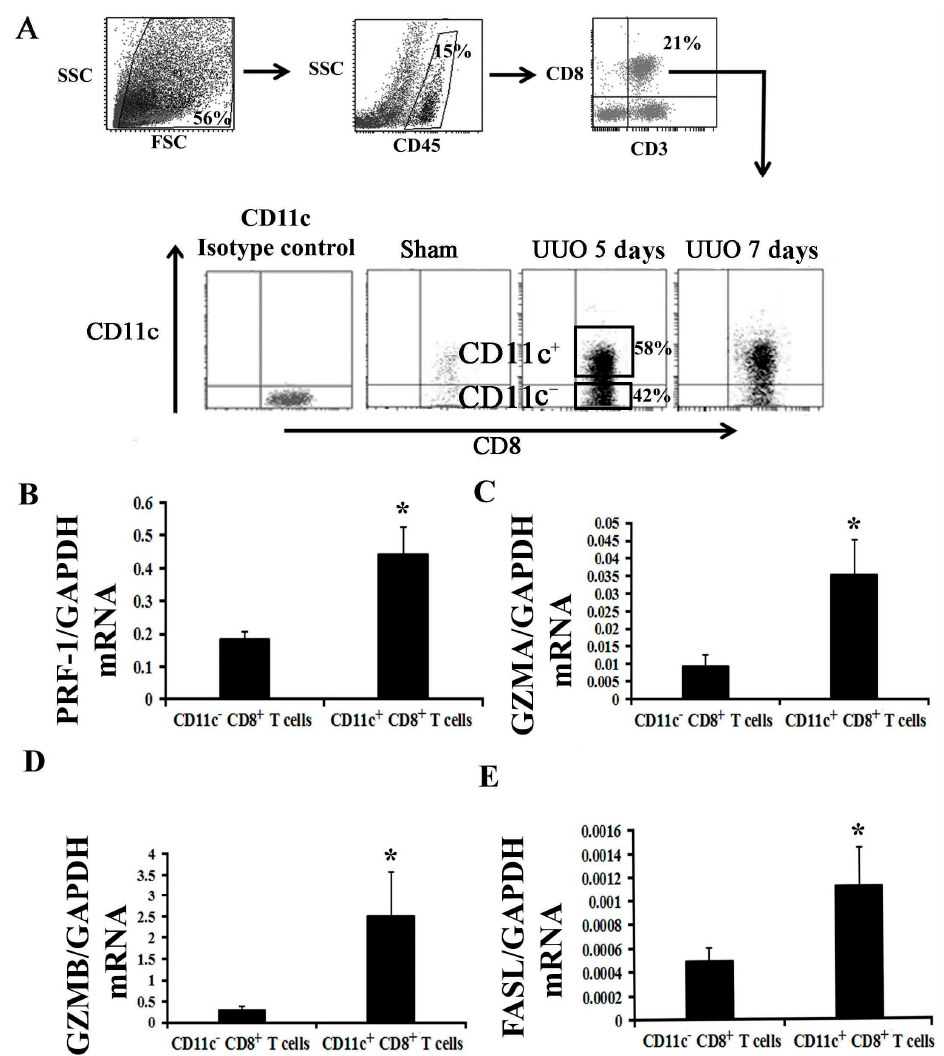
Figure 5. CD11c + CD8 + T cells mainly constitute the population of CD8 T cells expressing the mRNA of cytotoxin related factors in obstructed kidney. ( A ) CD11c − CD8 + T cells and CD11c + CD8 + T cells in kidney at UUO 5 days were separated through cell sorting after incubation of the total number of cells in antibody cocktail (anti-CD45, CD3e, CD8a, and CD11c). CD11c isotype control group: incubated in antibody cocktail (anti-CD45, CD3e, and CD8a and an isotype control of CD11c antibody); ( B – E ) mRNA levels of cytotoxin related factors (PRE-1, GZMA, GZMB, and FASL) as determined in those CD11c − CD8 + T cells or CD11c + CD8 + T cells by quantitative RT-PCR (* p < 0.05 vs. CD11c − CD8 + T cells; n = 5).